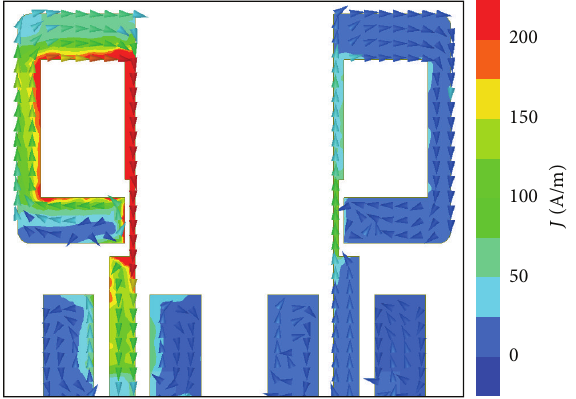
Figure 4: Surface current distribution when only one element is excited at 2.45 GHz.